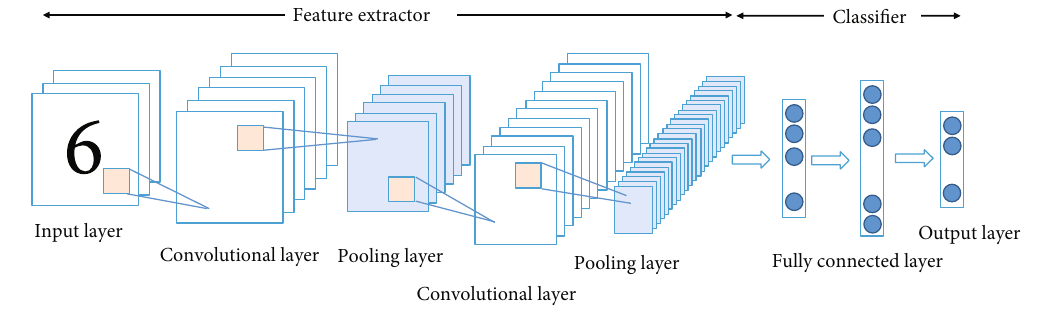
Figure 3: Basic structure of convolutional neural